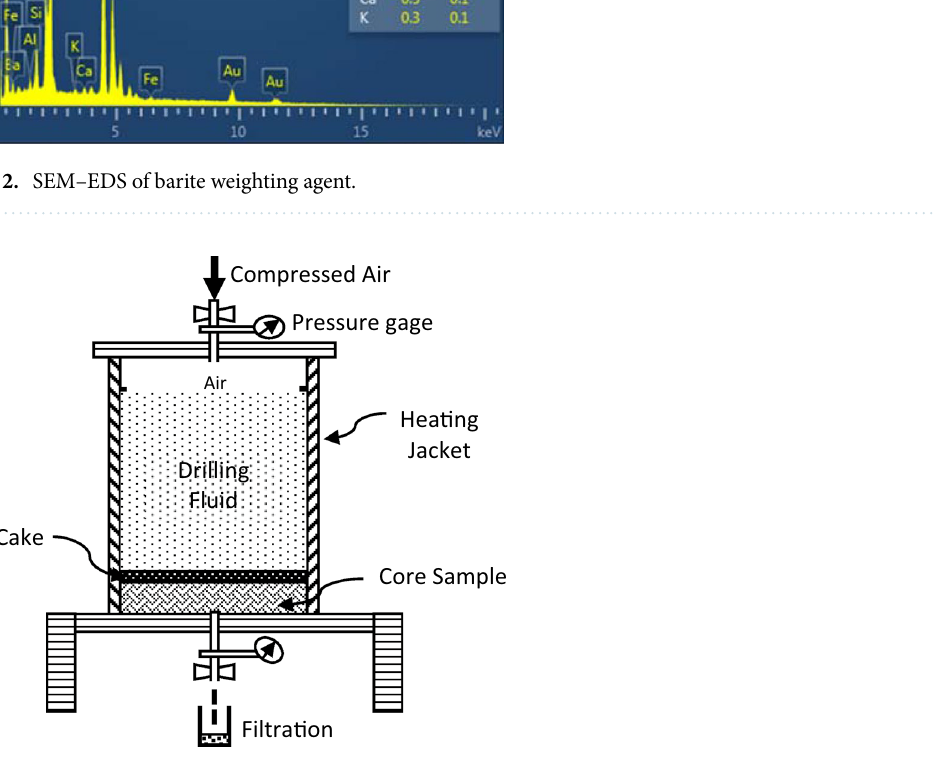
Figure 3. Schematic of static HPHT fluid loss system used for filter cake formation and removal